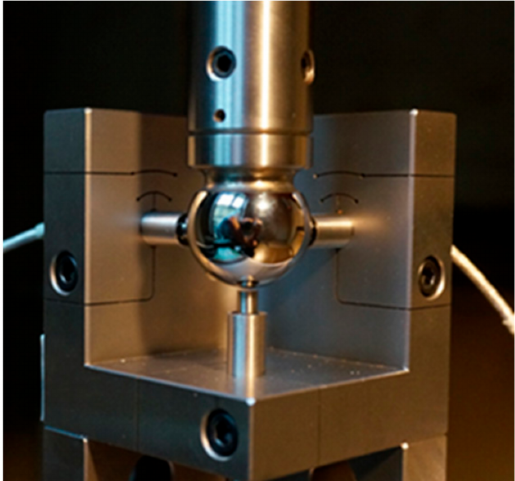
Figure 66. Error movement measuring set with three